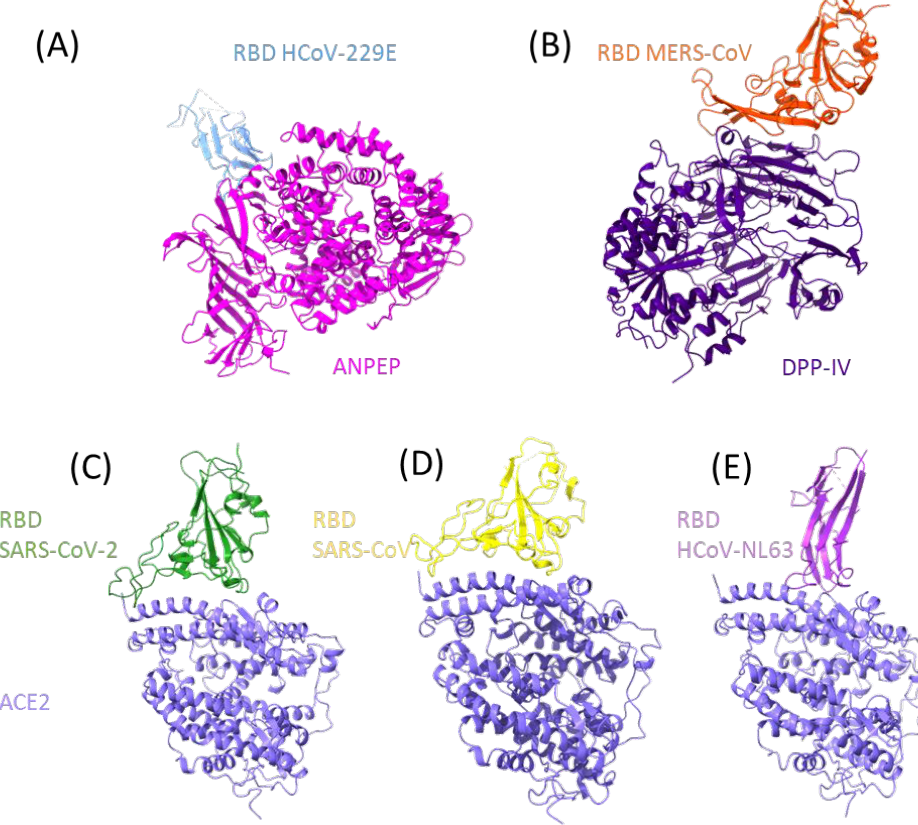
Figure 1. RBD interactions of human coronaviruses with their human protein receptor. The structures of protein–protein interaction of human coronaviruses to the human receptor is presented. At the top from left to right the RBD of HCoV-229E (( A ), PDB: 6ATK) with ANPEP and the RBD of MERS-CoV (( B ), PDB: 4KR0) with DPP- IV, at the bottom the RBD of SARS2-S (( C ), PDB: 6M0J), SARS-S (( D ), PDB: 2AJF) and HCoV-NL63 (( E ), PDB: 3KBH) interacting with ACE2.